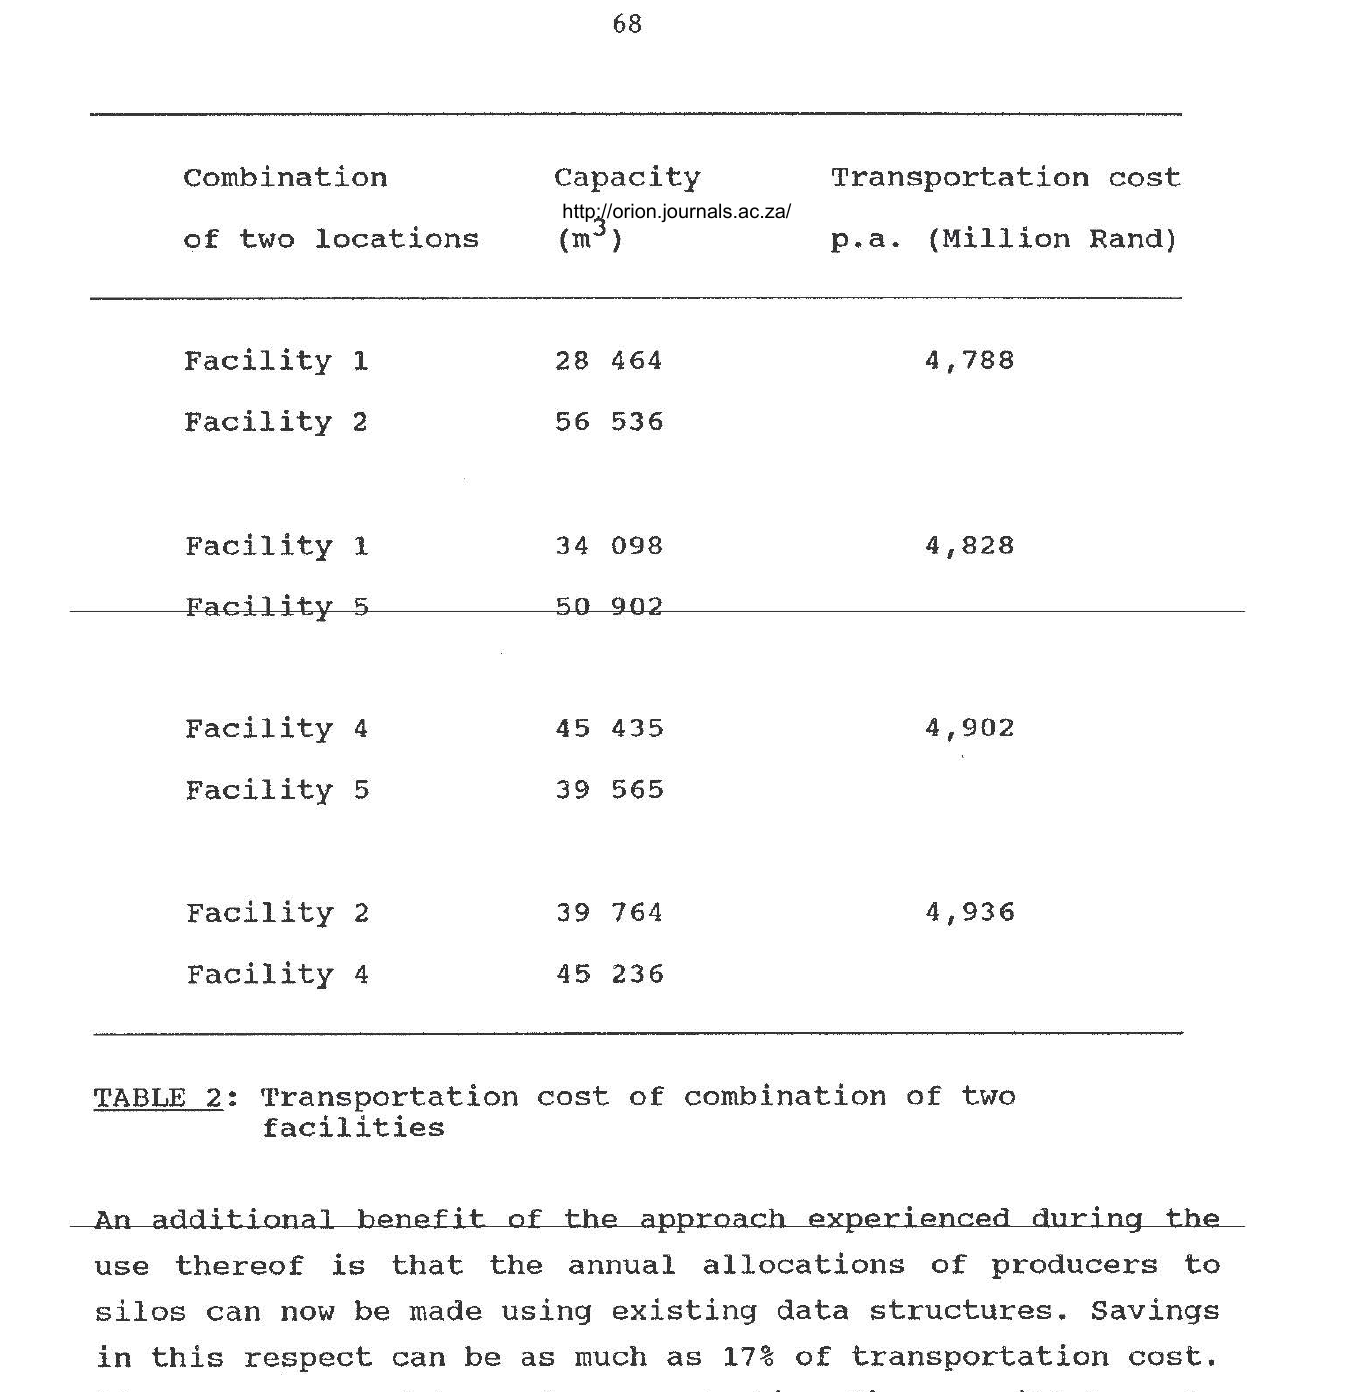
TABLE 2: Transportation cost of combination of